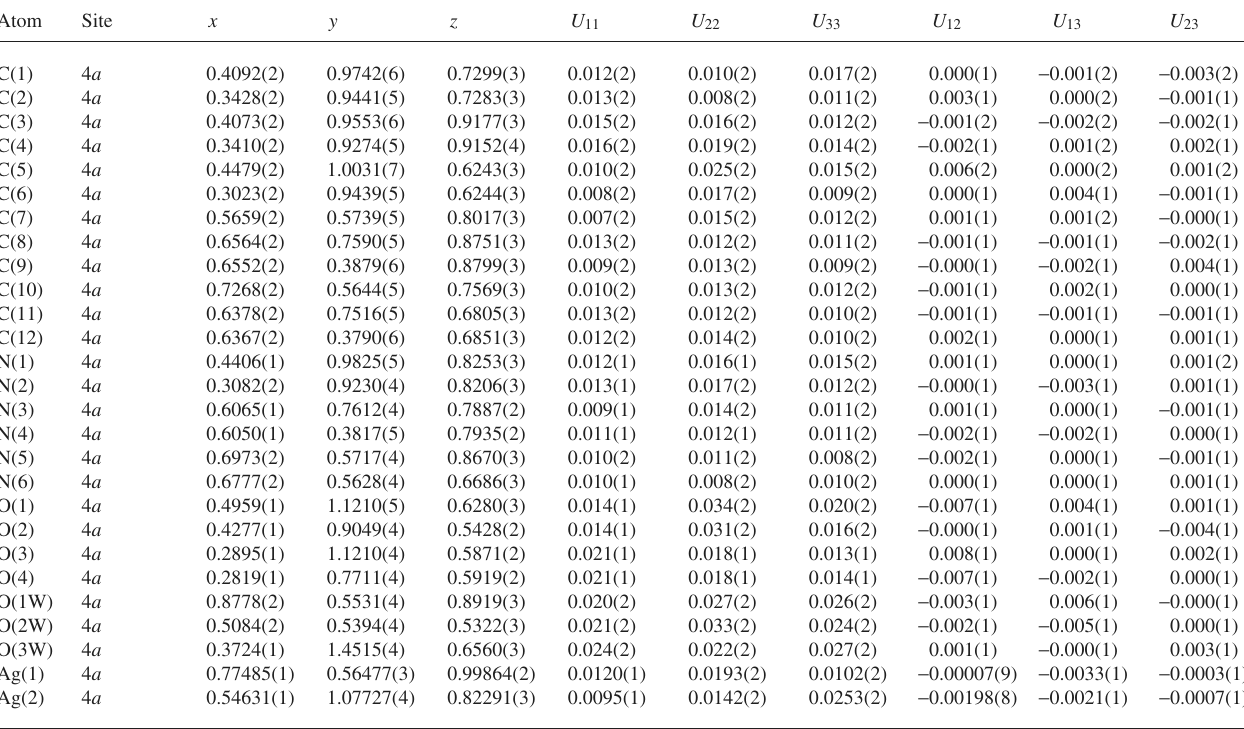
Table 3. Atomic coordinates and displacement parameters (in Å 2 )